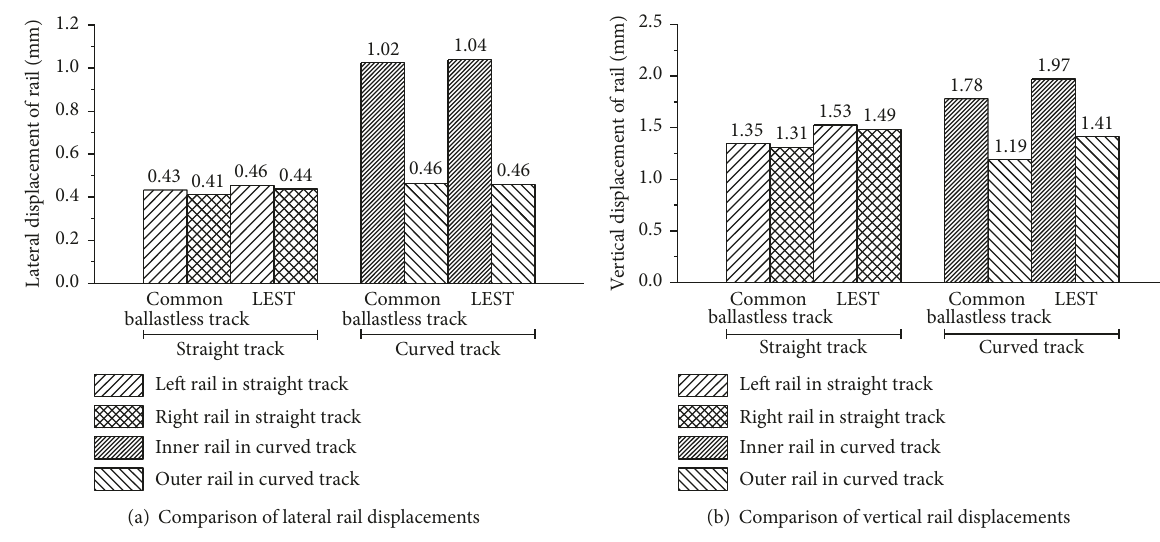
Figure 10: Comparison of the average rail displacements between common ballastless track and LEST.